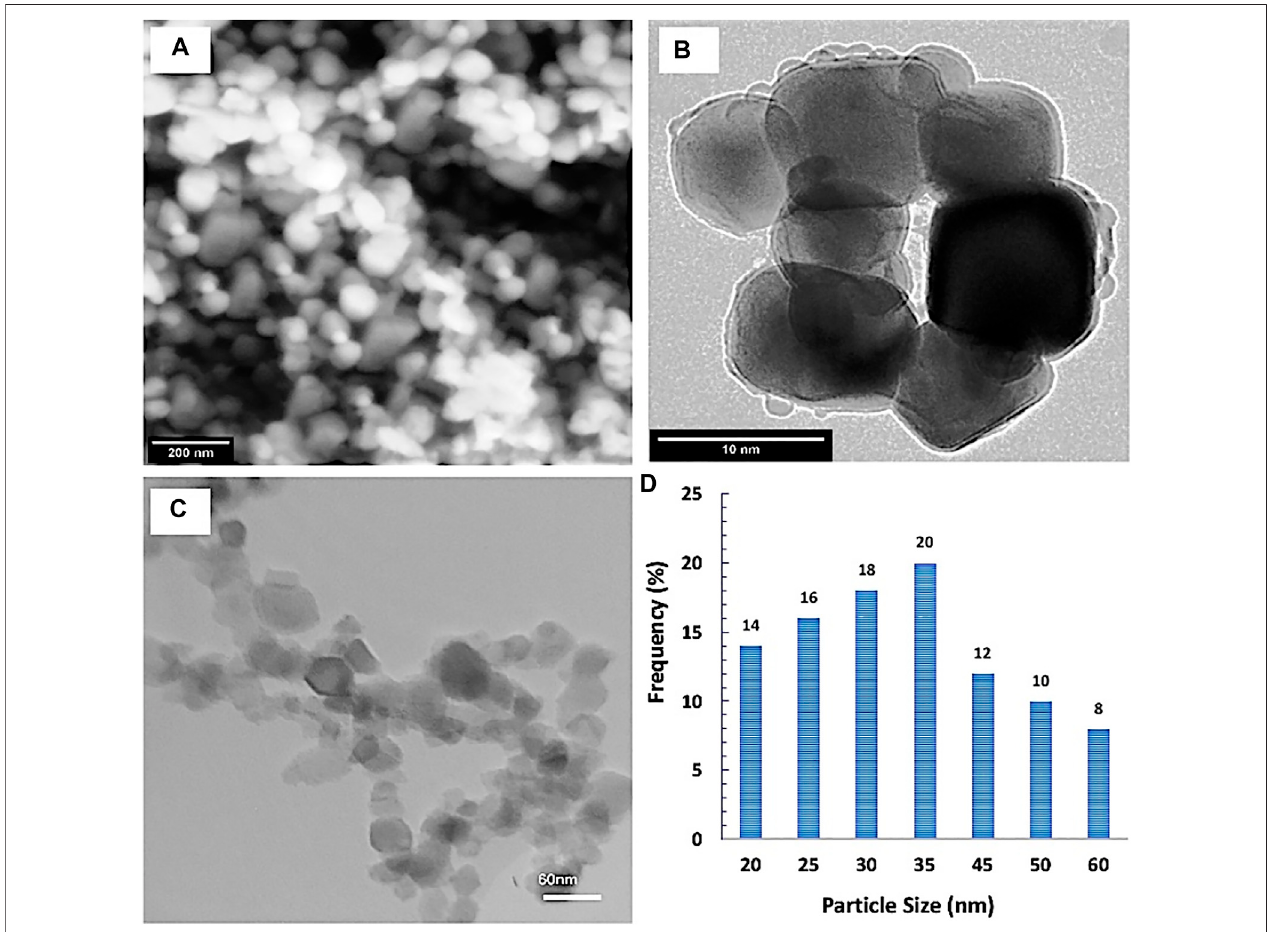
FIGURE 2 | (A) Field emission scanning electronic microscope (FESEM) image, (B) high-resolution transmission electron microscopy (HRTEM) image, and (C,D) particle size distribution by TEM image analysis of the investigated silica nanoparticles.